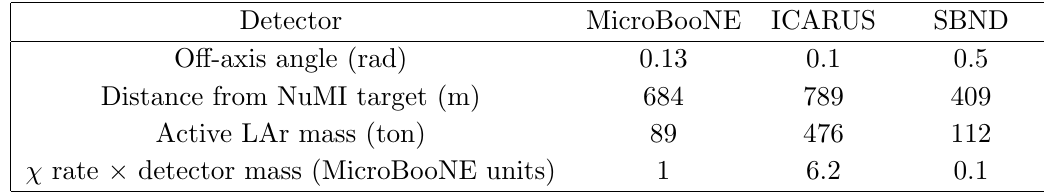
Table 1 . Parameters of the three Fermilab SBN liquid argon detectors with respect to the NuMI beamline (120 GeV